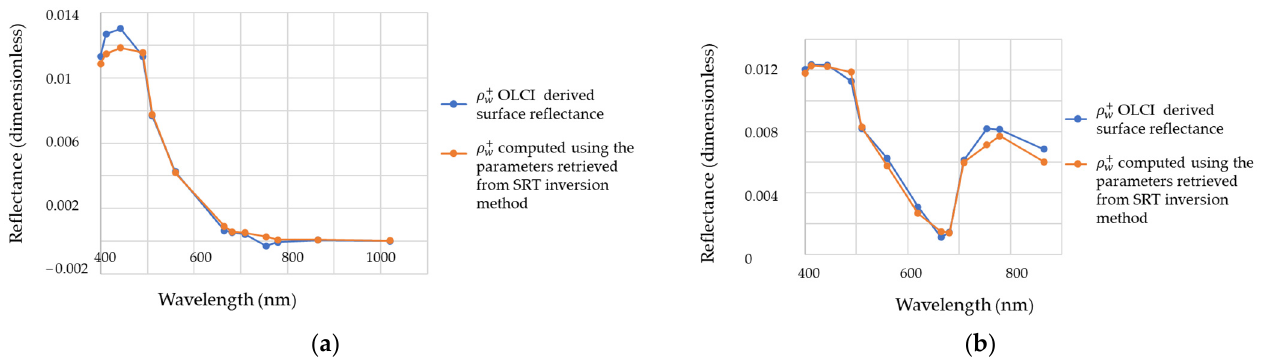
Figure 6. OLCI derived surface reflectance ρ ω+ and computed surface reflectance using the retrieved bio-optical parameters from SRT inversion: ( a ) for a Sargassum -free pixel and ( b ) for a Sargassum contaminated pixel.